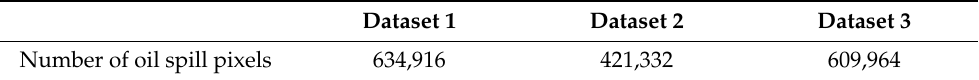
Table 2. The number of oil spill pixels for each dataset used in this